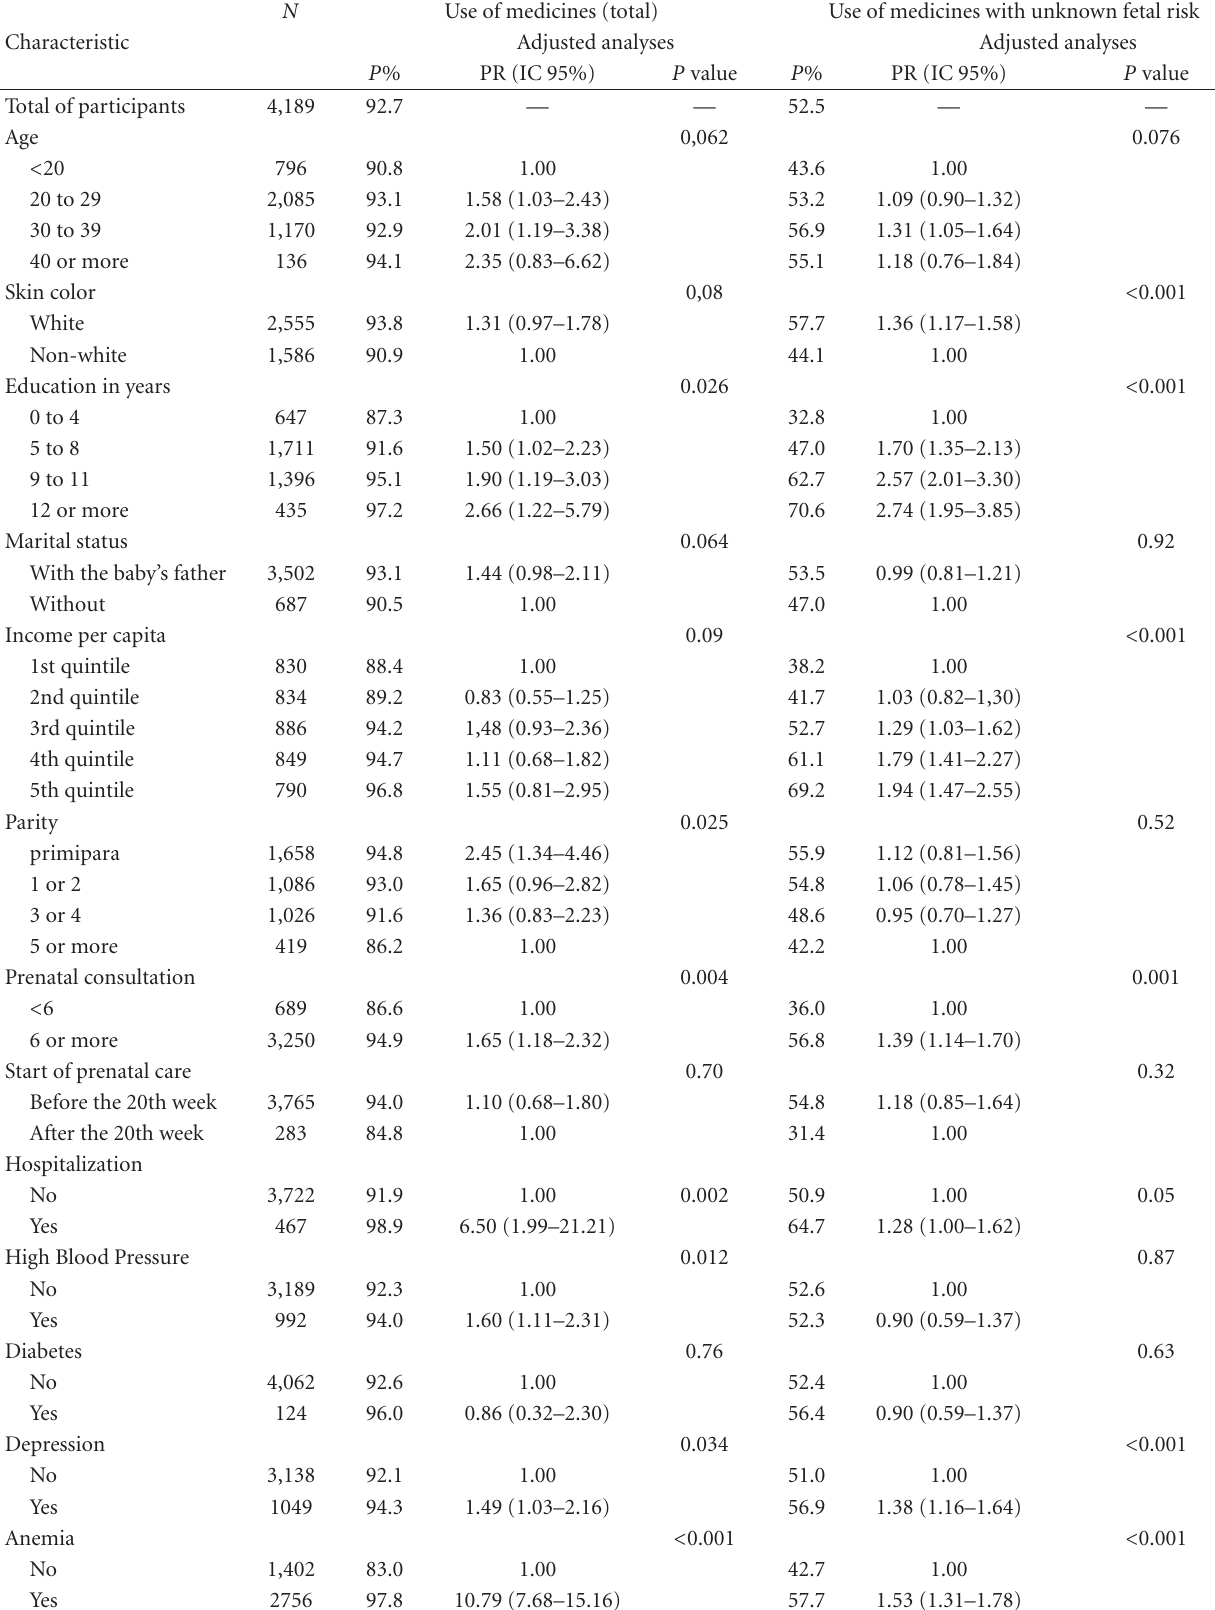
Table 3: Description of the sample and the health conditions of the mothers participating in the 2004 Birth Cohort ( N ), prevalence ( P %) and adjusted analyses of the use of medicines during pregnancy considering all medicines and the medicines with unknown fetal risk used. Birth Cohort of Pelotas, RS